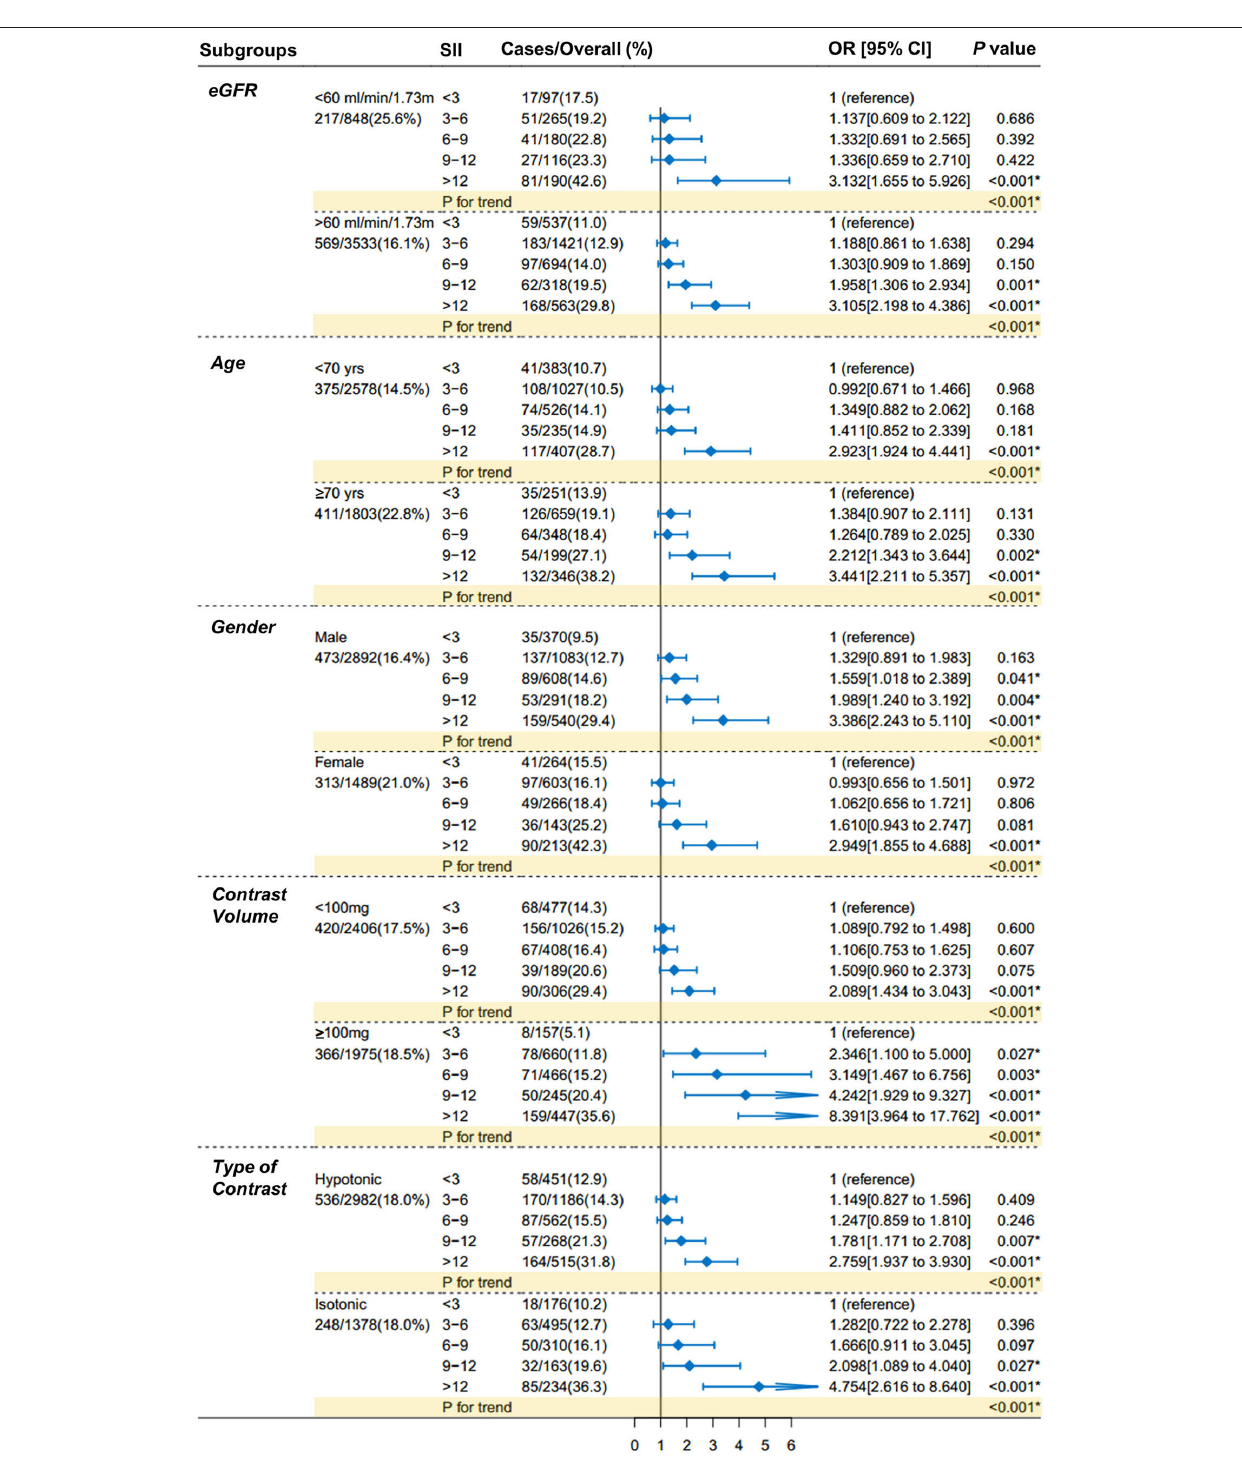
FIGURE 4 | Forest plots of SII for CI-AKI in prespecified subgroups. Patients are dichotomized according to eGFR [ < 60 or ≥ 60 ml/ (min × 1.73 m 2 )], age ( < 70 or ≥ 70 yrs.), gender (male or female), exposure volume of contrast agent ( < 100 or ≥ 100mg), and type of contrast agent (hypotonic or isotonic). The increasing trends in the CI-AKI risk with the increase of SII scores were consistent across all subgroups comparing with the main finding (all P for trend < 0.001). Multivariable logistic regression in subgroups adjusted the same covariates of Model 3 in Table 3 . SII indicates systemic immune-inflammation index; CI-AKI, contrast-induced acute kidney injury; eGFR, estimated glomerular filtration